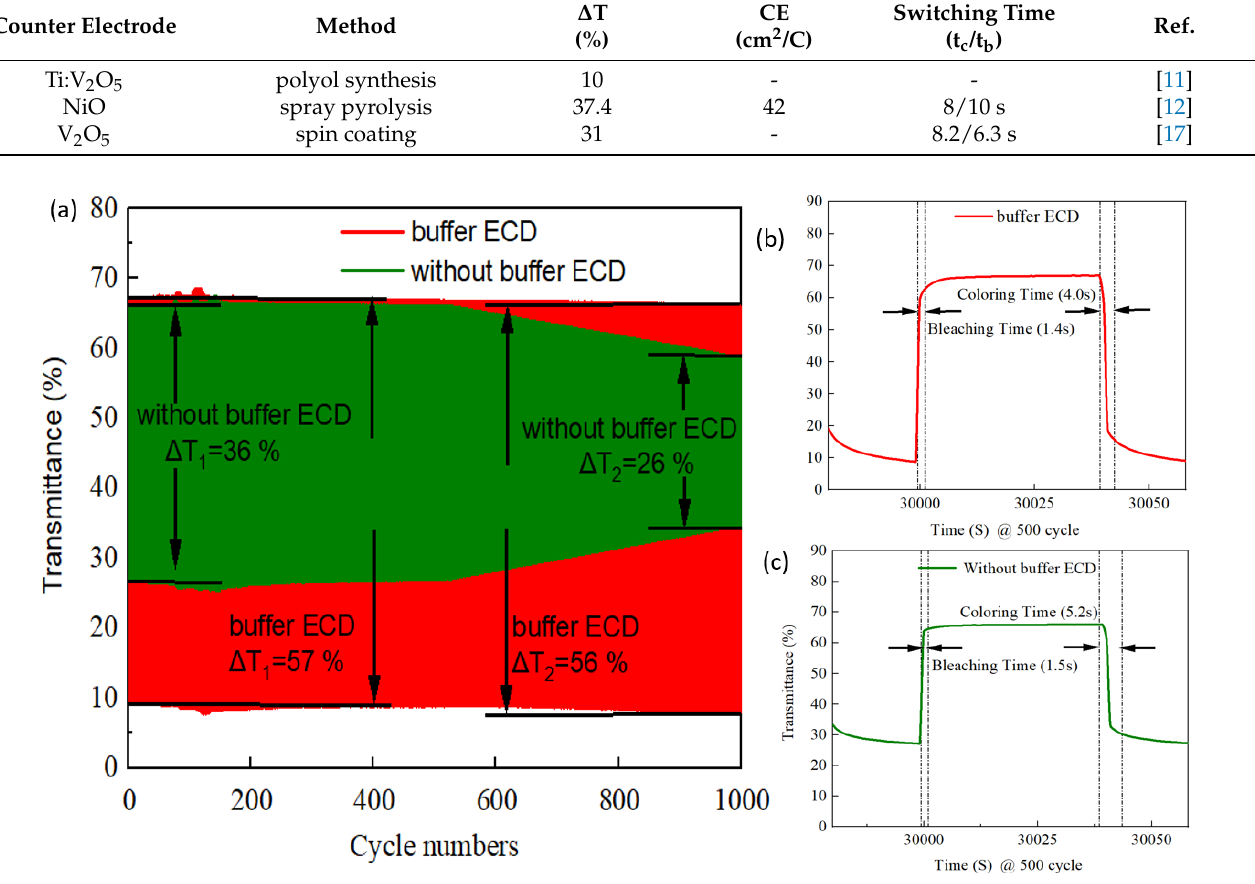
Figure 12. ( a ) The 1000-cycle durability comparison with buffered ECD and ECD without buffer, ( b ) buffered ECD and ( c ) ECD without buffer: switch response time @ 500 cycles.